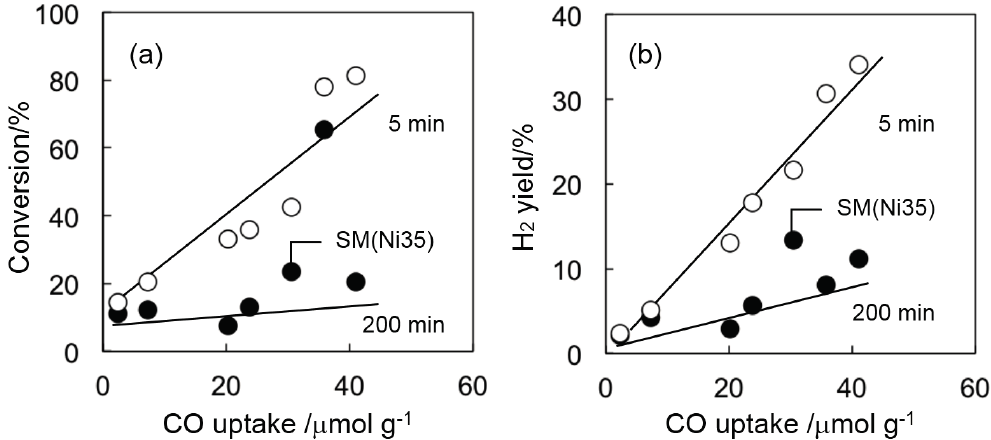
Figure 2. Total conversion and H 2 yield for steam reforming of ethanol over different Ni catalysts at 500 °C after 5 min ( □ ) and 200 min ( ■ ).